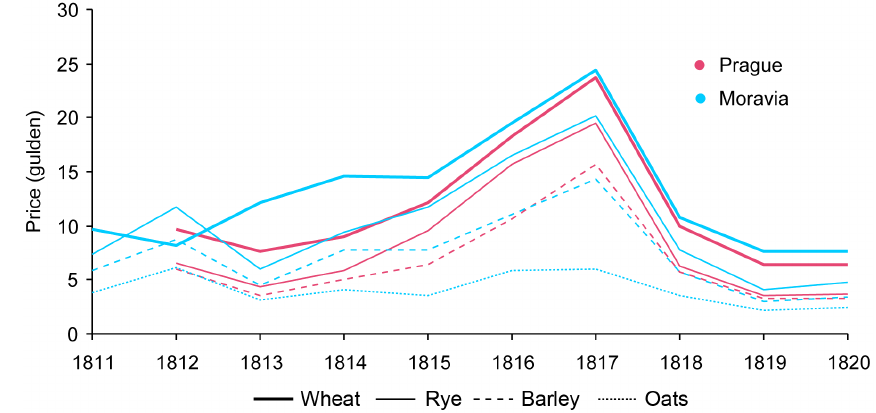
Figure 7. Fluctuations in prices of staple cereals (wheat, rye, barley, oats) in Prague (gulden/61.49 l) and in Moravia (gulden/hl) in the 1811–1820 period. Data: Prague – Schebek (1873), Moravia – Albert (1964). Table 1. The order of mean seasonal temperatures and precipitation for 1815–1818, the years after the Tambora eruption: (a) temperature in order of increasing values (from lowest to highest), Prague-Klementinum and central Europe; (b) precipitation in order of decreasing values (from highest to lowest totals), Prague-Klementinum and